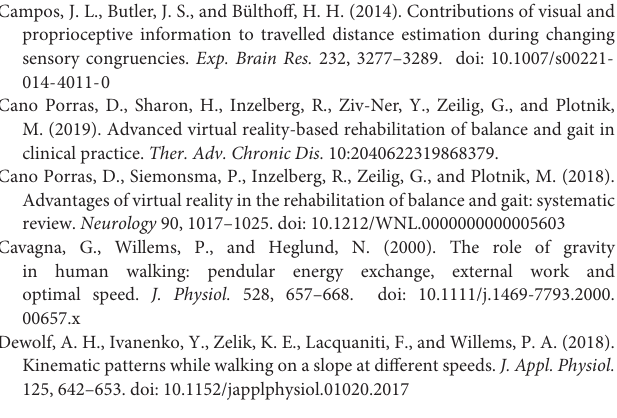
FIGURE S1 | Calculation of area under the curve (AUC). Representative data from individual participants. The same method for calculating AUC was used for free body velocity and walking speed in the other experimental conditions. FIGURE S2 | Calculation of the ratio of gravity-induced behavior. Walking speed is for a single representative participant post-transition from level to uphill walking (congruent T U V U condition). Calculation of free body velocity follows equation (5). Note that the turning point at 11 s (in the inset ratio graph) corresponds to the time at which walking stops decelerating due to gravity, and stabilization of locomotion begins. FIGURE S3 | Schematic model of neural perception-action mechanisms underlying the observed effects. A neural model that putatively accounts for our findings of locomotor modulations following perceived gravitational changes while walking. The core of this predictive system is an internal model of gravity that regulates locomotion in accord with estimates of physical laws of gravity. The model accounts for the mechanisms of indirect prediction and sensory reweighting, and incorporates the braking and exertion effects characterizing locomotor adaptations in our study. Relevant brain regions are shown. The inset panel is a schematic representation of the lumbosacral maps of LCPGs involved in the activation of muscles that play critical roles during uphill and downhill walking (Ivanenko et al., 2006; Pickle et al., 2016). Green lines point to brain areas involved in cue integration and sensory reweighting, the orange line emerges from the region proposed to subserve an internal model of gravity, blue lines are pathways involved in indirect prediction, and gold lines indicate proposed mechanisms of locomotor regulation and action. Dashed lines represent connectivity between areas in the central nervous system. The Discussion section on neural mechanisms (and the Putative neural model section in the Supplementary Materials ) describes the scientific rationale for this model. MLR, mesencephalic locomotor region; LCPGs, locomotion central pattern generators, dITS, dorsal part of the inferior temporal sulcus [homologous to macaque dorsal medial superior temporal area (Huk et al., 2002)]; aIPS, anterior part of the intraparietal sulcus [homologous to macaque ventral intraparietal area (Grefkes and Fink, 2005)]. TABLE S1 | Steady-state